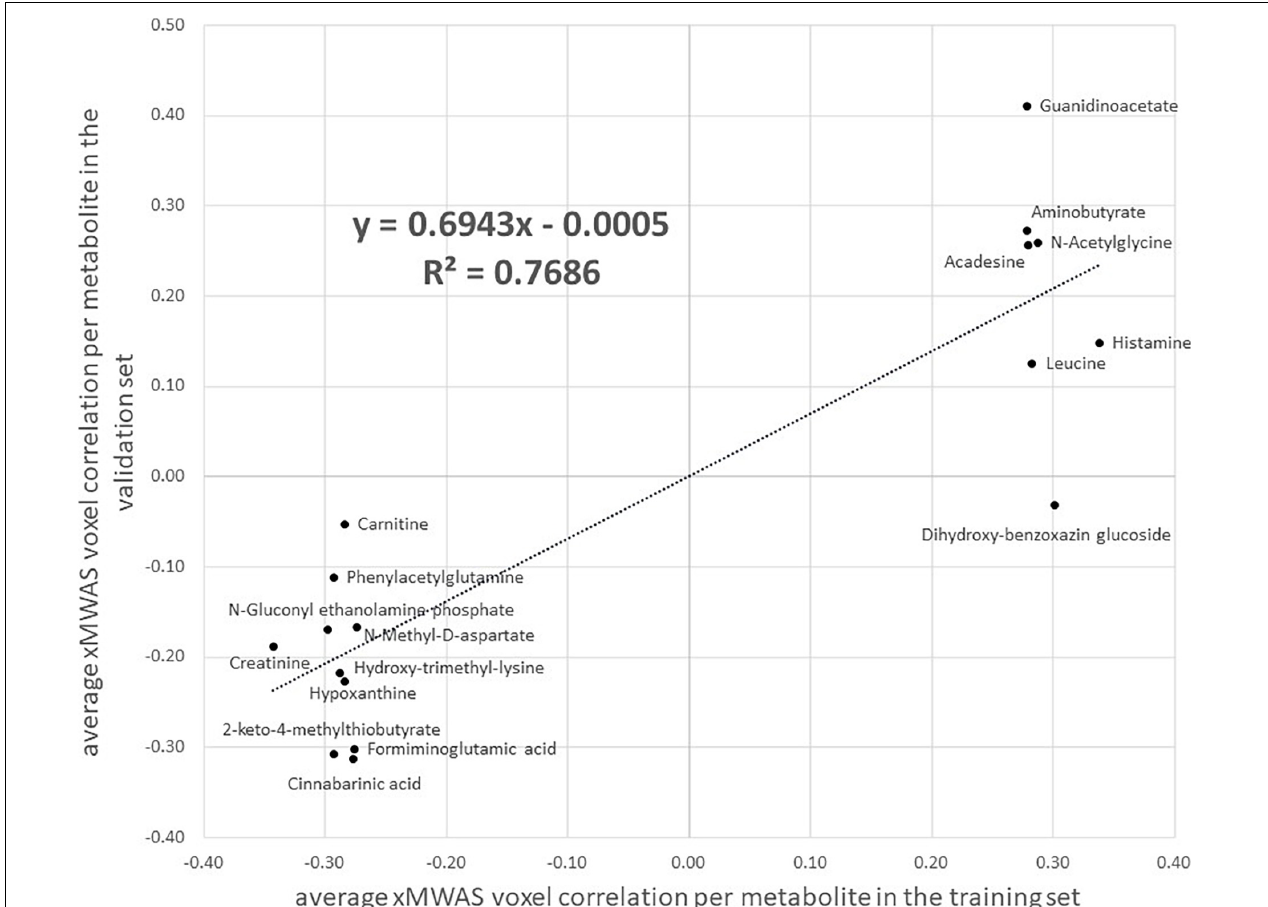
FIGURE 3 | A scatter plot of the average correlation, as estimated by xMWAS, between MRI imaging voxels and 17 amino acid/urea cycle metabolites found via metabolic pathway analysis that met the xMWAS parameter thresholds ( r > | 0.271| with a P -value < 0.05) in the training set. The x -axis is the average correlation in the training set and the y -axis is the average correlation in the validation set. Three metabolites, indoleacetic acid, 5-hydroxyindoleacetate, and S -adenosylhomocysteine from Table 3 did not meet the xMWAS parameter thresholds in the training set and were thus not